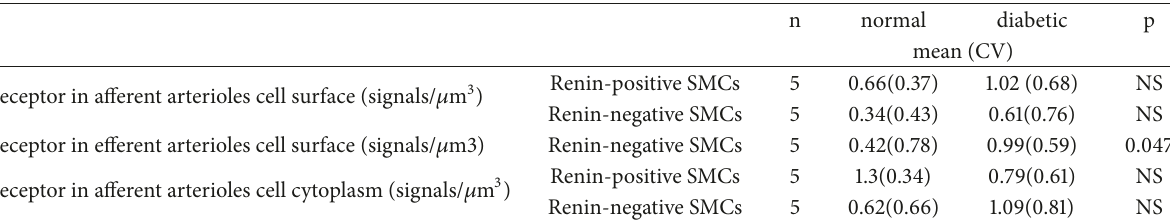
n normal diabetic p mean (CV)